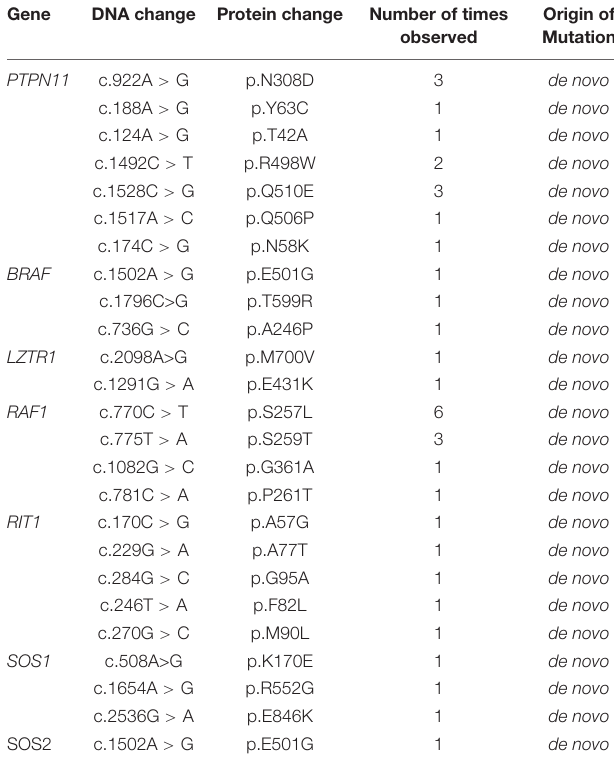
TABLE 2 | Pathogenic variants detected in Noonan syndrome patients collected from the Guangdong Provincial People’s Hospital. Gene DNA change Protein